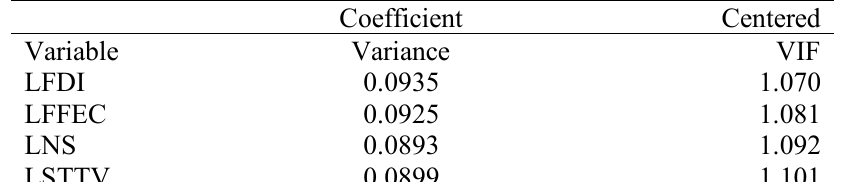
Table 2. Variance inflation factors.